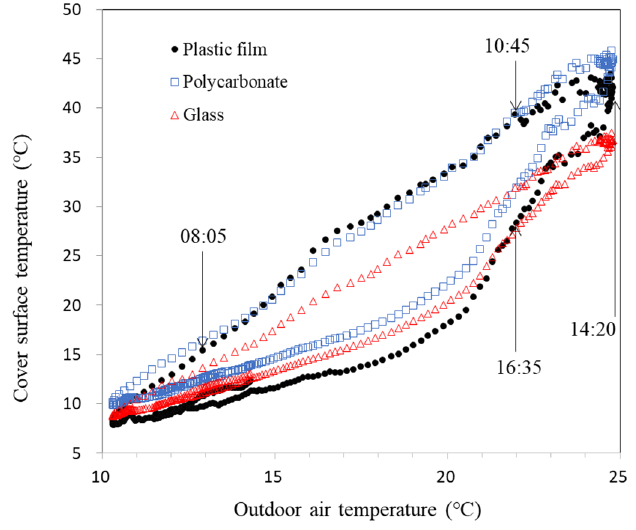
Figure 9. Comparison of inner cover surface temperatures as a function of outdoor air temperatures in greenhouses covered with different covering materials (12–13, 19–20, and 26–27 October 2019).